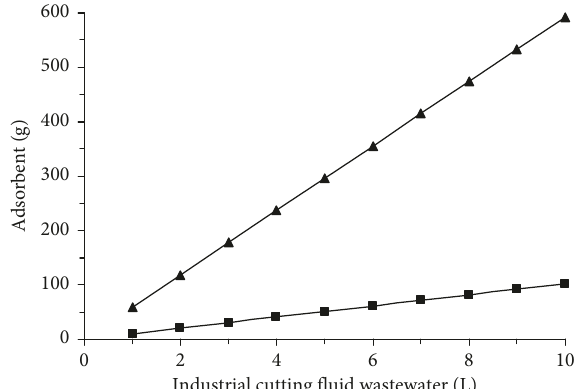
Figure 12: Adsorbent dosage versus CFW volume under labora- tory ( ■ ) and pilot ( ▲ ) scales.